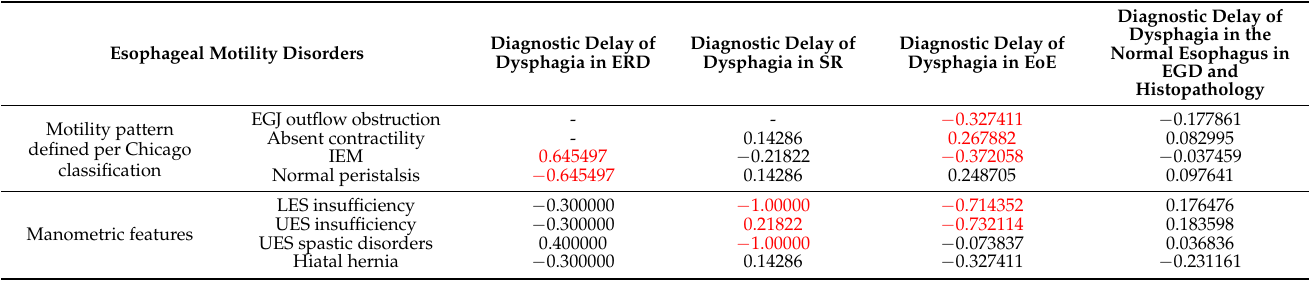
Table 5. Spearman’s rank correlation coefficients between the diagnostic delay of dysphagia in ERD, SR, EoE, normal esophagus and manometric patterns and features. Significant—in